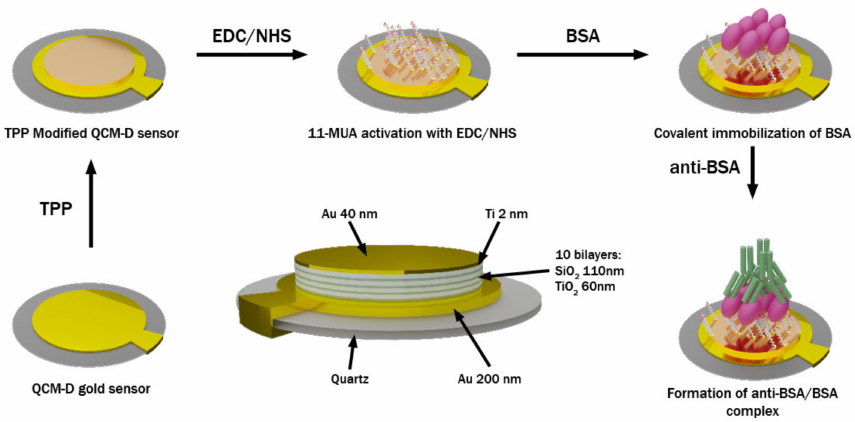
Figure 1. A scheme representing formation of BSA and anti-BSA proteins layers on a modified QCM-D sensor chip.